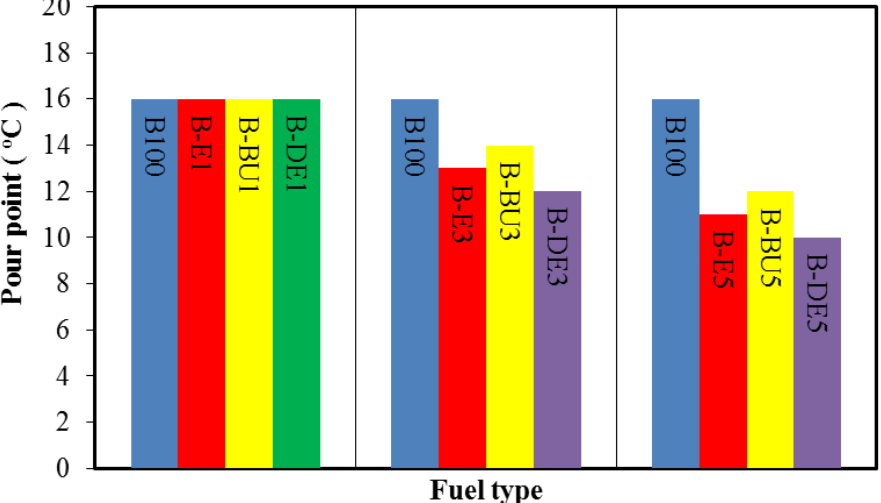
Figure 3. Variation in palm oil methyl ester pour point with increasing blending ratio for different